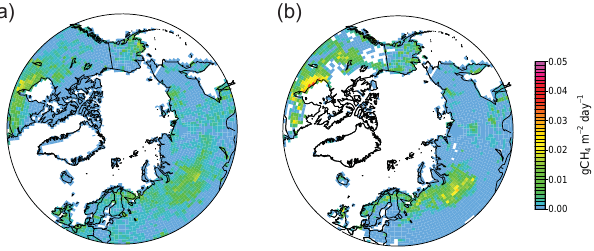
Figure 3. Wetland emissions estimates (units gCH 4 m − 2 day − 1 ) from LPX-Bern (a) and LPJ-DGVM (b) .